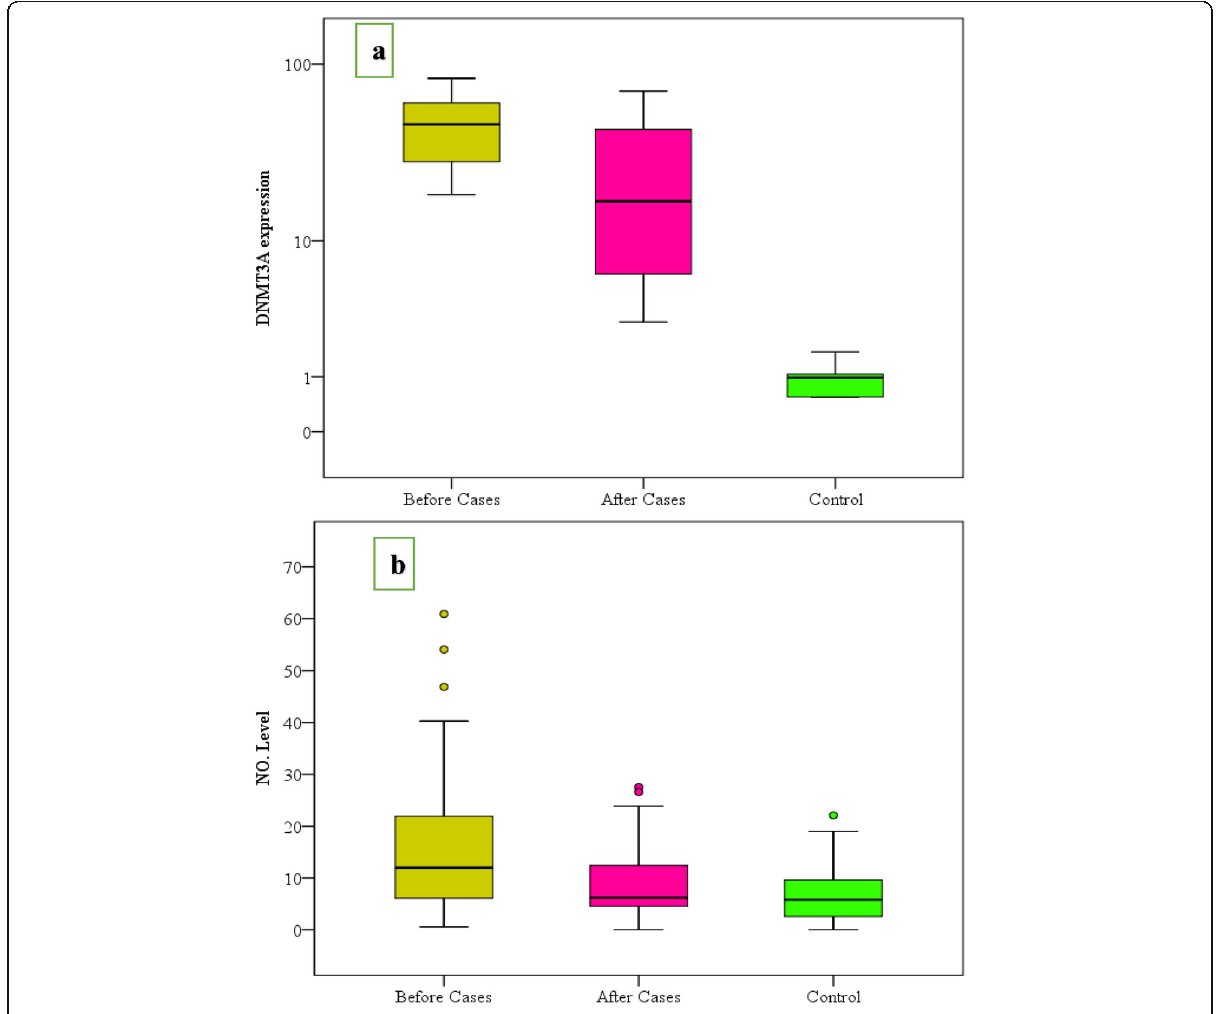
Fig. 1 a Comparison between mutated, un-mutated, and control groups as per DNMT3a expression before and after treatment. b Comparison between mutated, wild-type, and control groups as per NO levels before and after